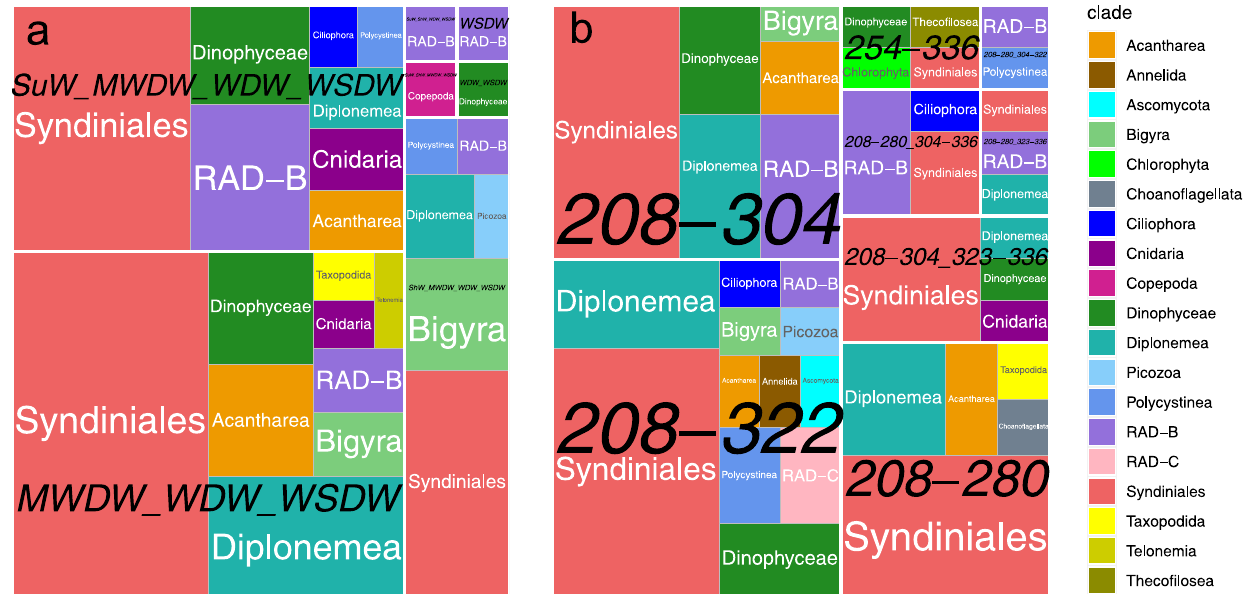
Fig. 3 Square pie charts illustrating taxonomy of OTUs leading according to the Indicator Value index. One hundred such OTUs were identi fi ed for the fi ve water masses (panel a ), and this analysis was repeated for the fi ve intervals of oxygen concentration (panel b ) separated by the ecological boundaries (Fig. 2). An OTU may be an indicator for a subset of water masses or oxygen concentration intervals, and such subsets are labeled in black. Taxonomic groups are labeled and color-coded according to the legend. The source data underlying this fi gure see in Suppl. Data 6 and Suppl. Data